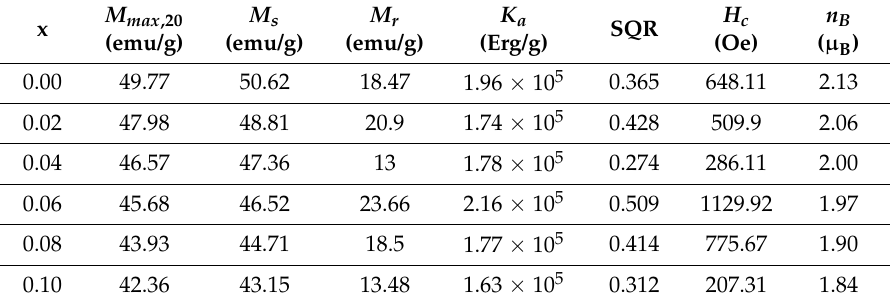
Table 2. Magnetic parameters of the Co 0.5 Ni 0.5 Nb x Fe 2 − x O 4 (0 ≤ x ≤ 1.0) nanoparticles at room temperature (RT) ( M max ,20 : max magnetization at 20 kOe, M s : saturation magnetization, M r : remanence magnetization, K a : magnetic anisotropy constant, SQR: squareness ratio, H c : coercivity and n B